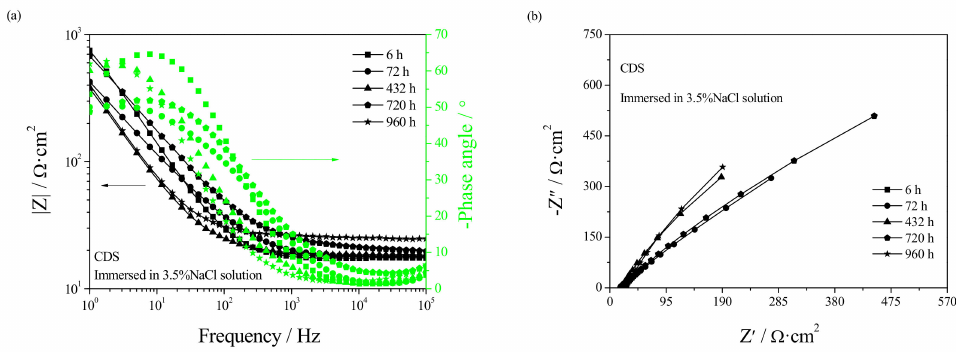
Figure 14. Bode ( a ) and Nyquist ( b ) plot of CDS immersed at di ff erent times in 3.5% NaCl